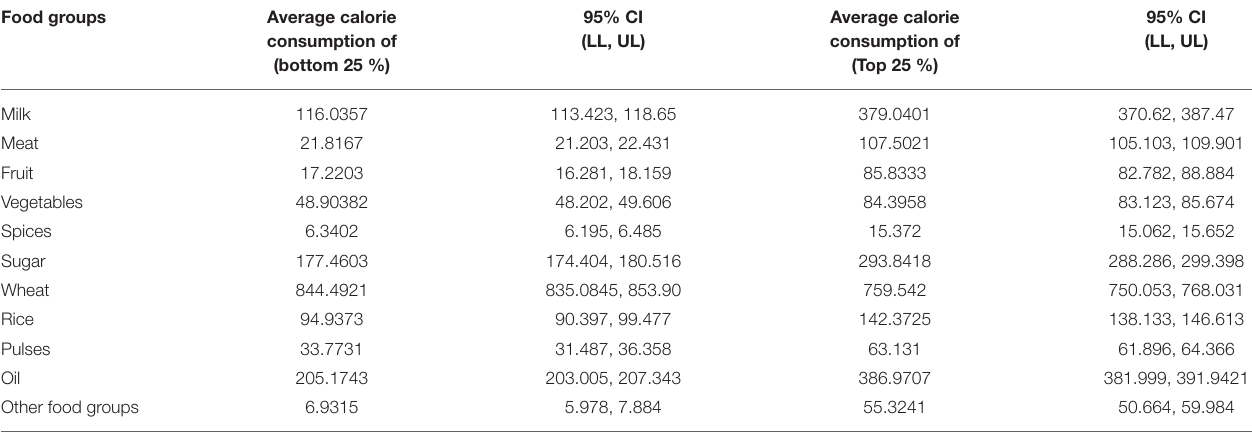
TABLE 5 | Average calories consumption from each food group at different income